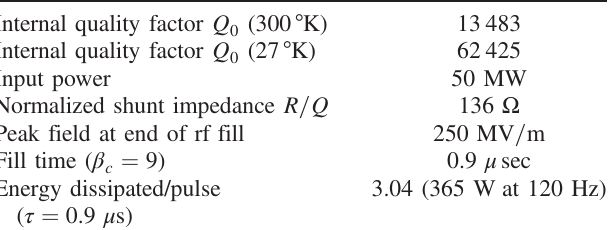
Fig. 19. The last two entries assume β ¼ 9 and τ ¼ 0 . 9 μ